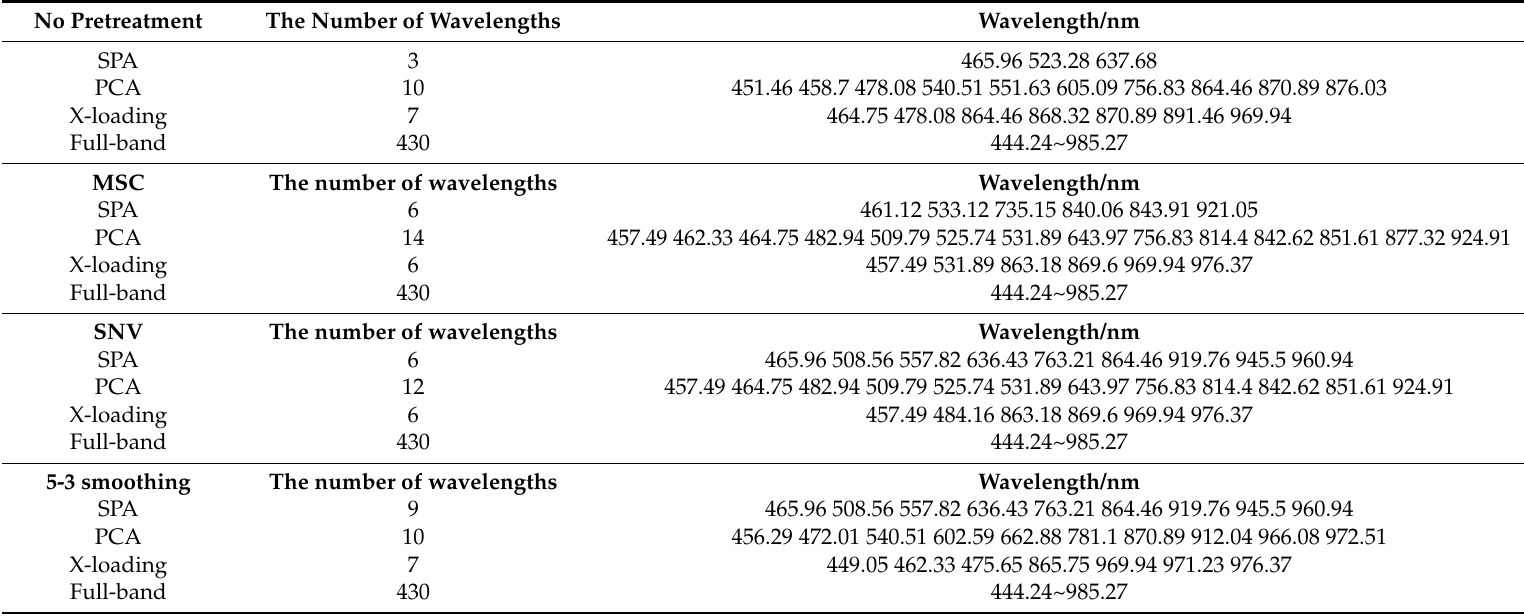
Table A2. The selected wavelengths using different methods under different pretreatments of